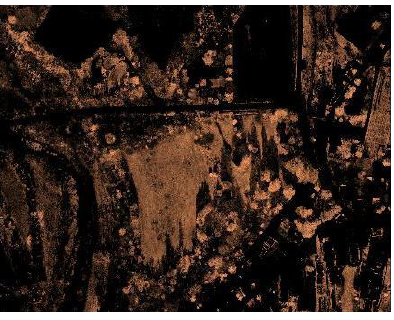
Figure 2: Elaboration of the NDVI index